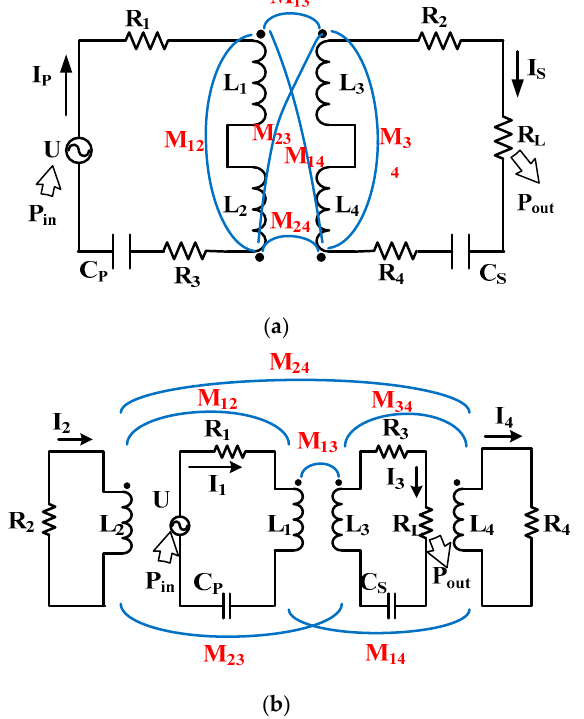
Figure 2. Equivalent circuit models for two kinds WPT systems with shielding coils: ( a ) the circuit model of series-opposing structure WPT systems; ( b ) the circuit model of inductive structure WPT systems.